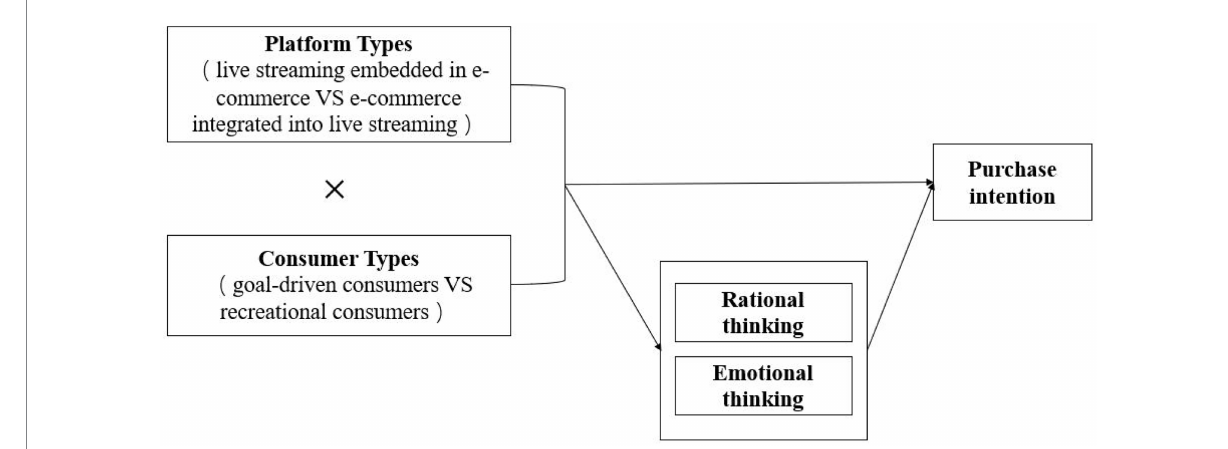
FIGURE 1 Theoretical